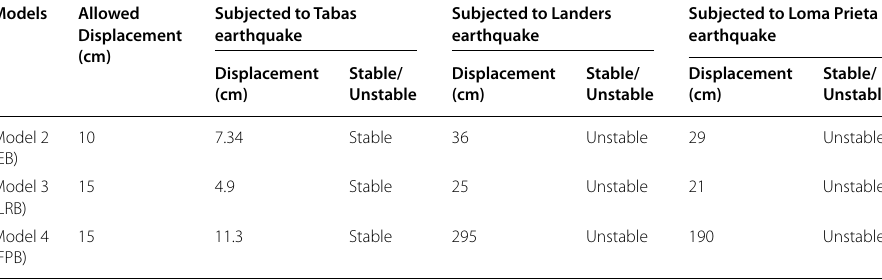
Table 1 The maximum lateral displacement of the deck in isolated bridges